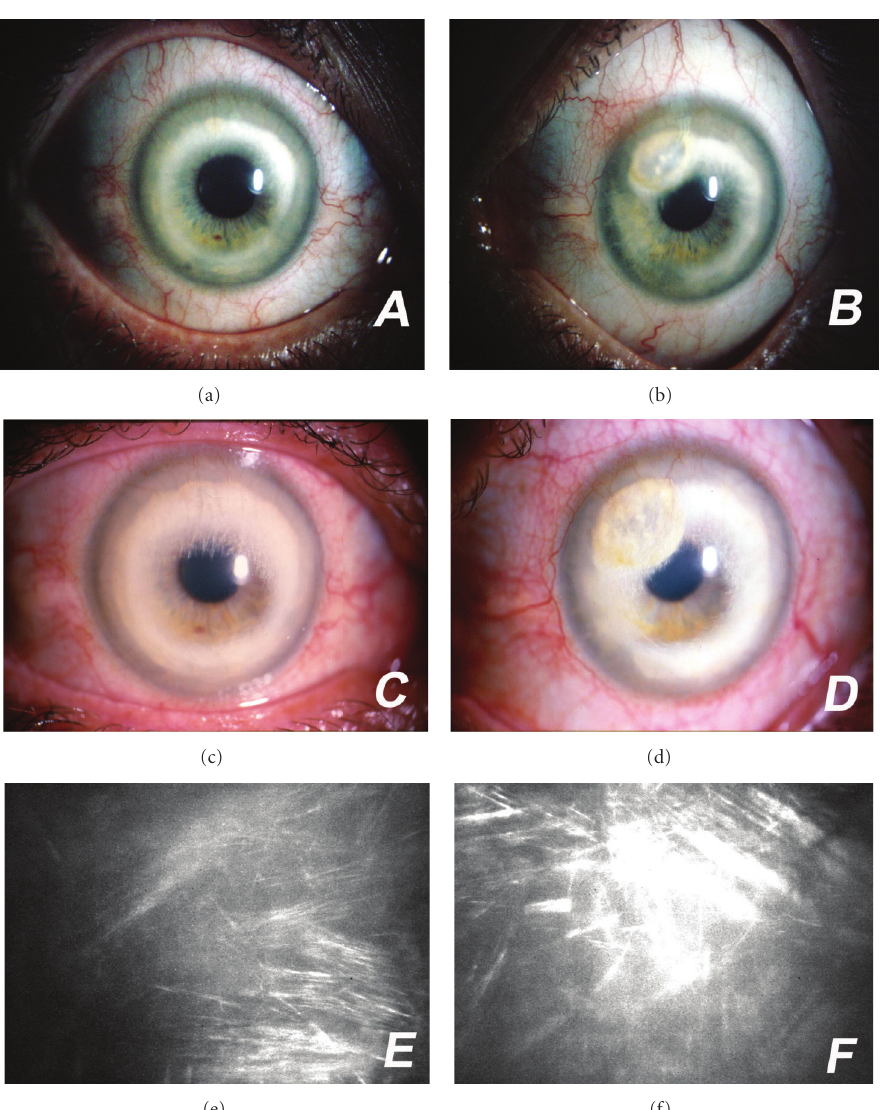
Figure 2: (a and b) Annular lipid infiltration in the corneal stroma of both eyes with cholesterol crystals in the paracentral area and deep corneal blood vessels from the limbus to the deposits. (c and d) Progression of the infiltration in both eyes, threatening the visual axis. (e and f) Confocal microscopy revealed crystalline structures in the stroma